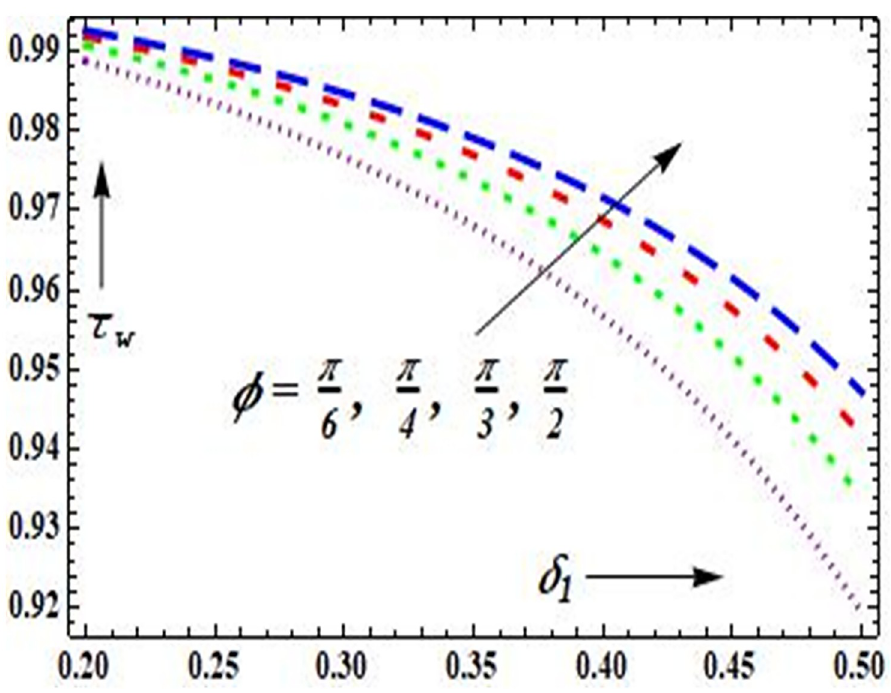
Fig 14. Plot of � τ on ϕ & δ 1 with M = 0.2, d 1 = 0.2, F = 0.3, d 2 = 0.6, L 2 = L 1 = 0.2, r = 2.0, Q = 0.1. w